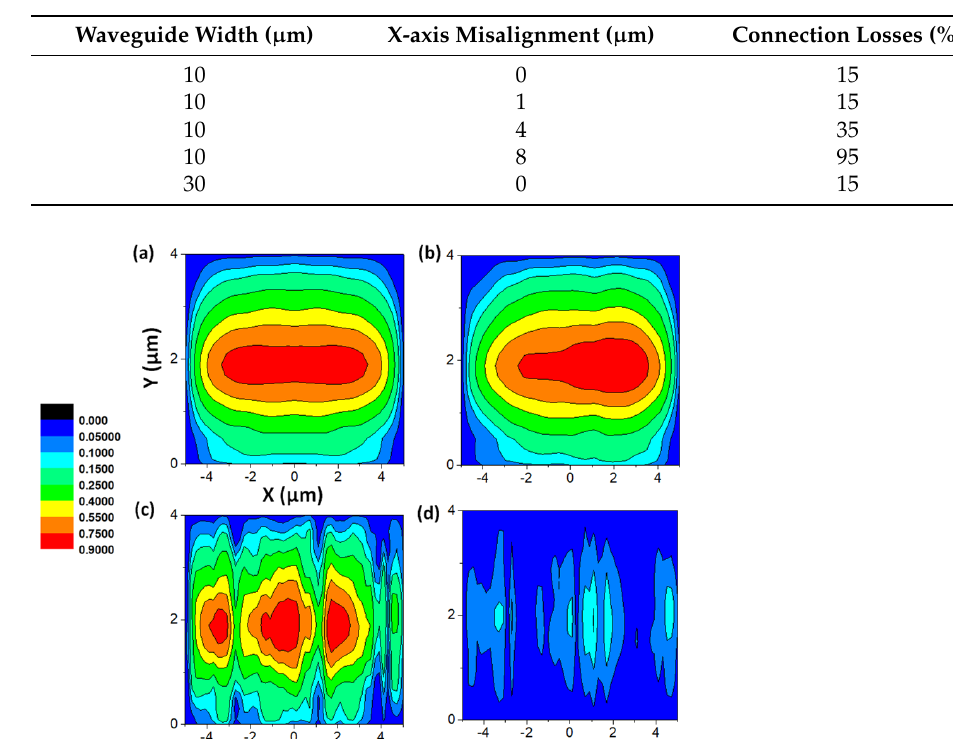
Table 1. Effect of the X-axis misalignment (0 µ m, 1 µ m, 4 µ m, 8 µ m) on the connection losses between SMF28 and TiO 2 –SiO 2 waveguides at 600 nm.